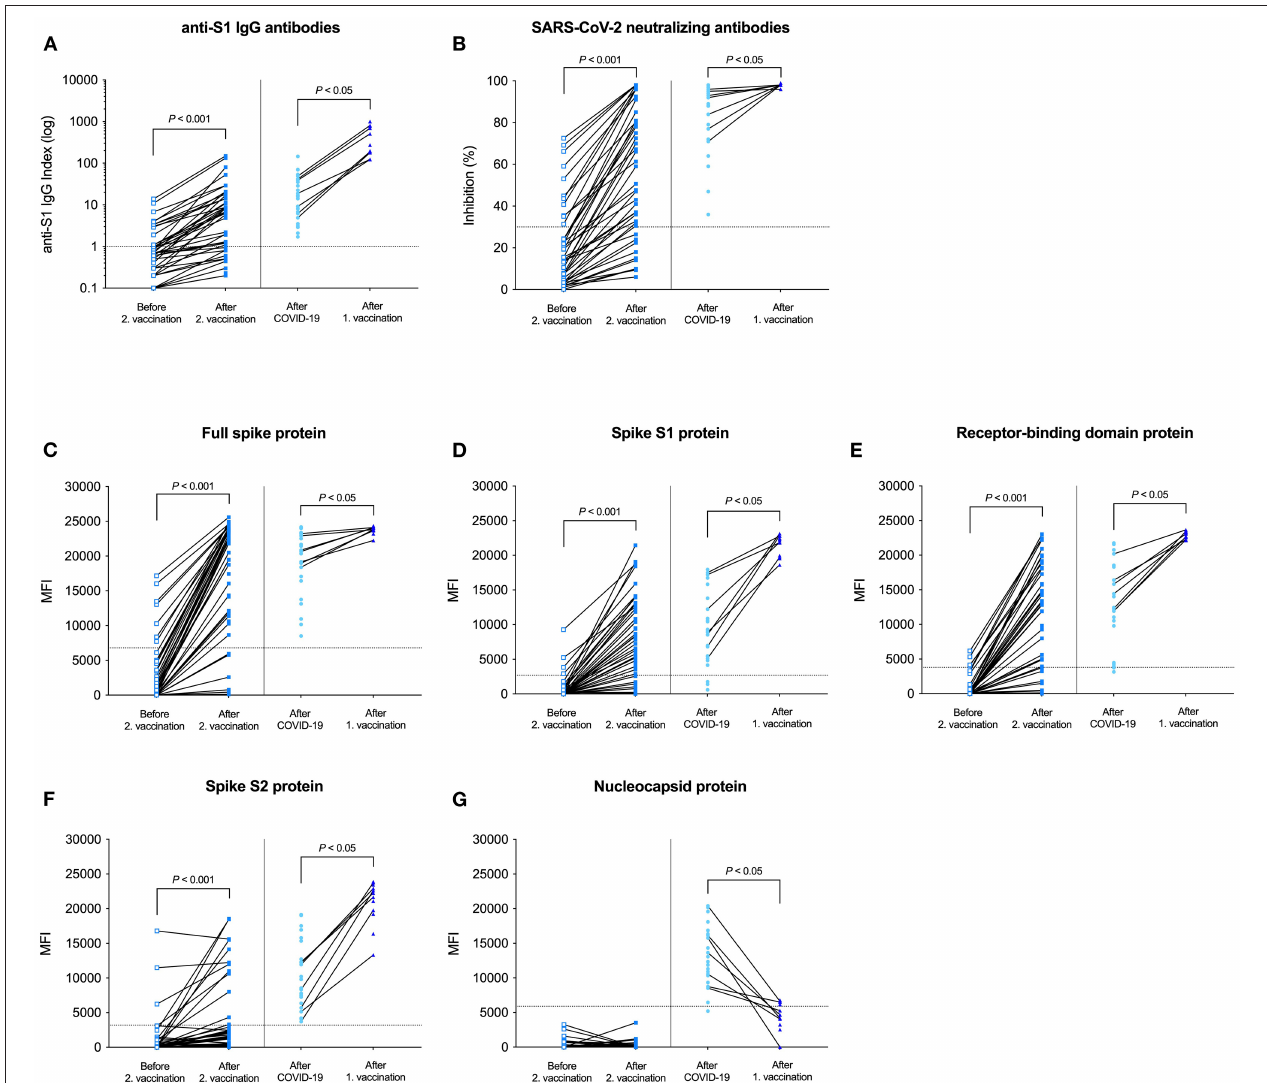
FIGURE 5 | Antibody levels and antibody courses of all measurements from before second vaccination to after second vaccination and from after COVID-19 to after single-dose vaccination in patients with prior infection. SARS-CoV-2 IgG antibodies (A) , SARS-CoV-2 neutralizing capacity of vaccine-induced antibodies (B) , bead-based detection of antibodies against the full spike (C) , the S1 spike (D) , the receptor-binding domain of the spike (E) , the S2 spike (F) , and the nucleocapsid protein of SARS-CoV-2 (G) in hemodialysis patients before second vaccination, after second vaccination, after COVID-19 in unvaccinated patients, and after single-dose vaccination in patients with prior infection. Available individual antibody courses from before second vaccination to after second vaccination and from after COVID-19 to after single-dose vaccination in patients with prior infection are connected by a black line, respectively.